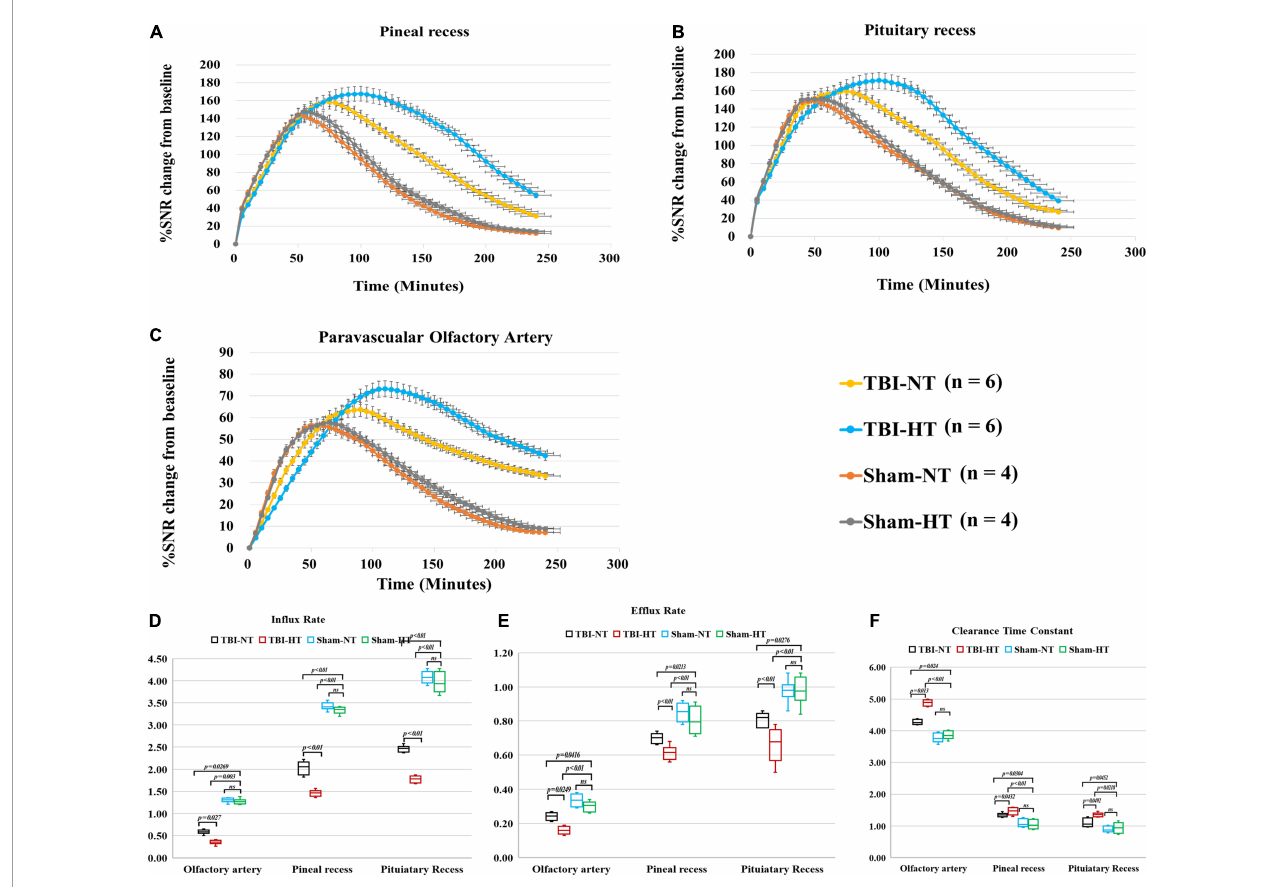
FIGURE3 Average group TECs derived from dynamic time series of T1WI with HA-Gd-DTPA. The changes in SNR% from baseline over time were obtained from sagittal T1WI sections encompassing critical anatomical structures, including the pineal recess (A) , pituitary recess (B) , and olfactory artery perivascular space (C) . Within the major experimental period, a longer time to peak enhancement, higher SNR% value, and more residual contrast at the end of the experiment, reflecting slower drainage of contrast agent in the brain, were detected in the TBI-HT group than in the TBI-NT group and in the TBI-NT group than in the Sham-NT or Sham-HT group. Quantitative analysis of the influence of TBI and hypothermia treatment on the glymphatic influx of large molecular contrast agents. Group comparison of influx rate (D) , efflux rate (E) , and clearance time constant (F) in the examined regions, including the perivascular olfactory artery, pineal recess, and pituitary recess. Data in (D–F) : Sham-NT n = 4, Sham-HT n = 4, TBI-NT n = 6, TBI-HT n = 6, pooled data from four independent experiments. All n values refer to the number of rats used. One-way ANOVA was used to calculate p -values with Bonferroni’s multiple comparison